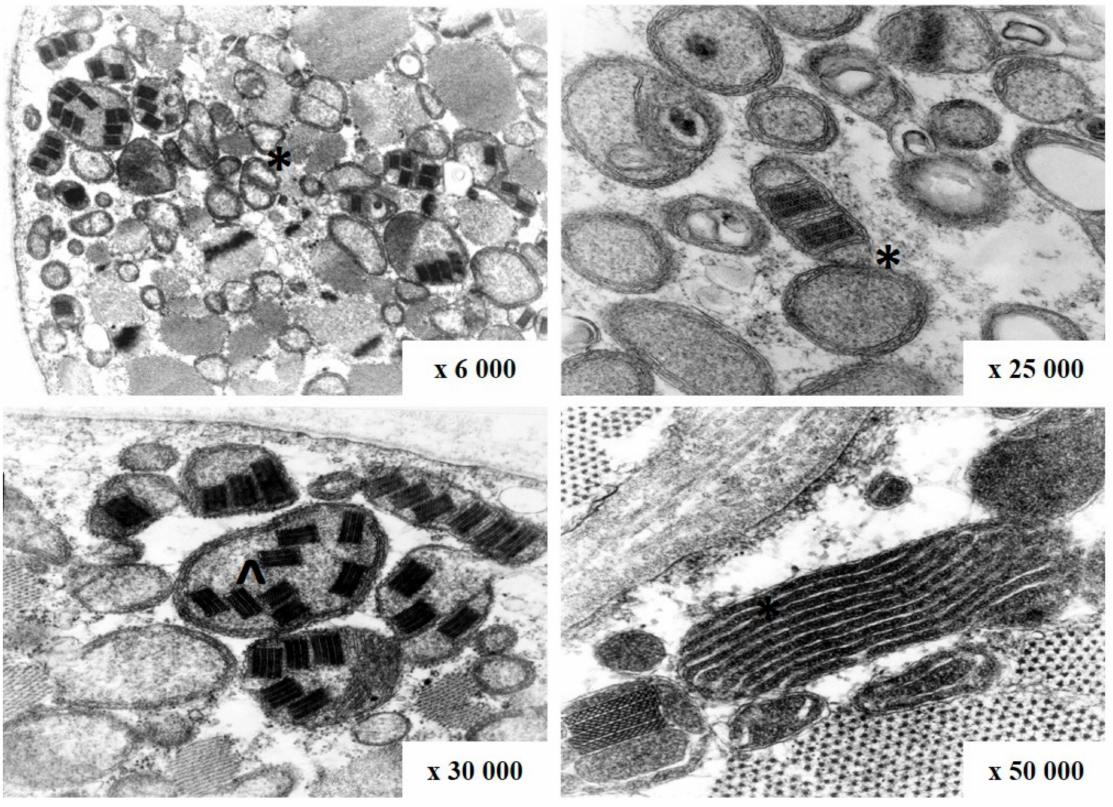
Figure 5. Abnormal mitochondria with irregular cristae (*) and paracrystalline inclusions (ˆ) on electron microscopy in patient with CPEO (patient number 25).